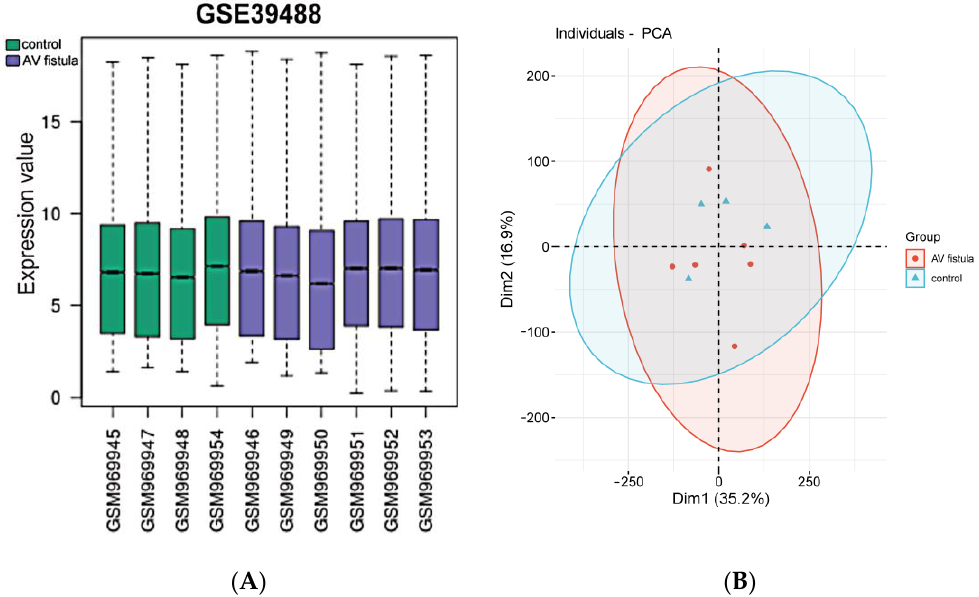
Figure 3. Consistency and repeatability analysis: ( A ) all samples from GSE39488 dataset were analyzed after log2 transformation, and the results suggest that mean values were approximately the same; ( B ) PCA model for the veins of stenotic AVF versus normal veins. PCA: principal component analysis.